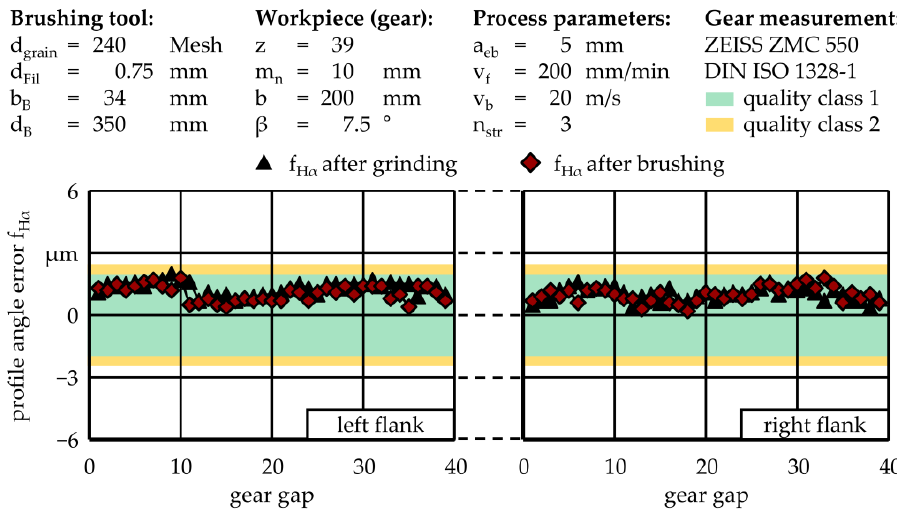
Figure 11. Comparison of the profile angle error f H α before and after the brushing process.